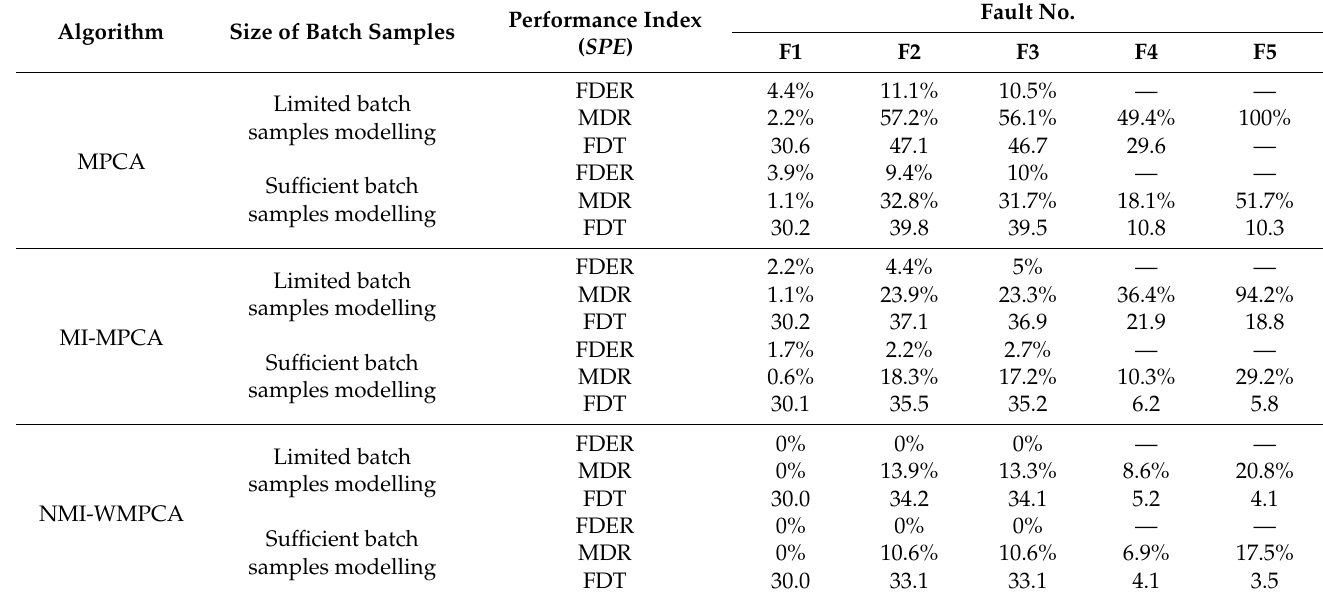
Table 7. Performance comparison experiment results of three methods under limited batch samples modelling and sufficient batch samples modelling.